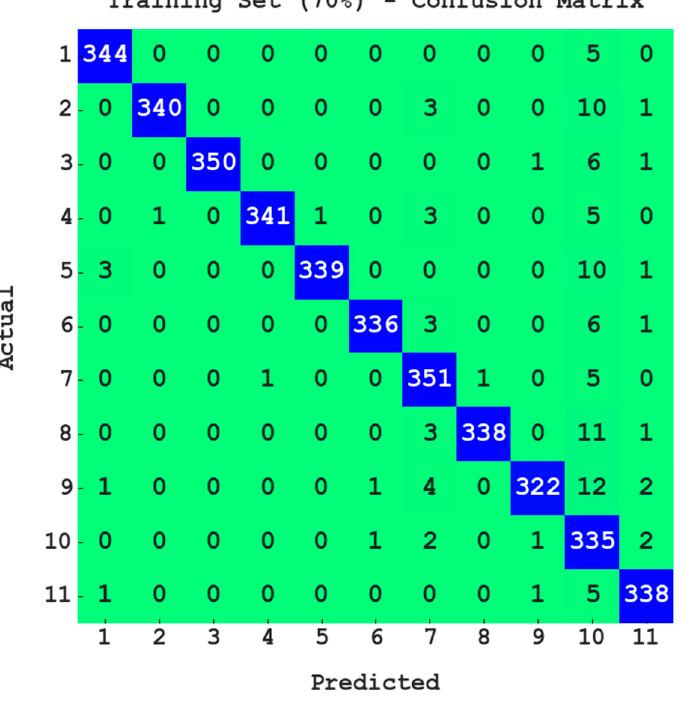
Figure 4. Confusion matrix of PODCNN-LWID approach with 70% of TR data.